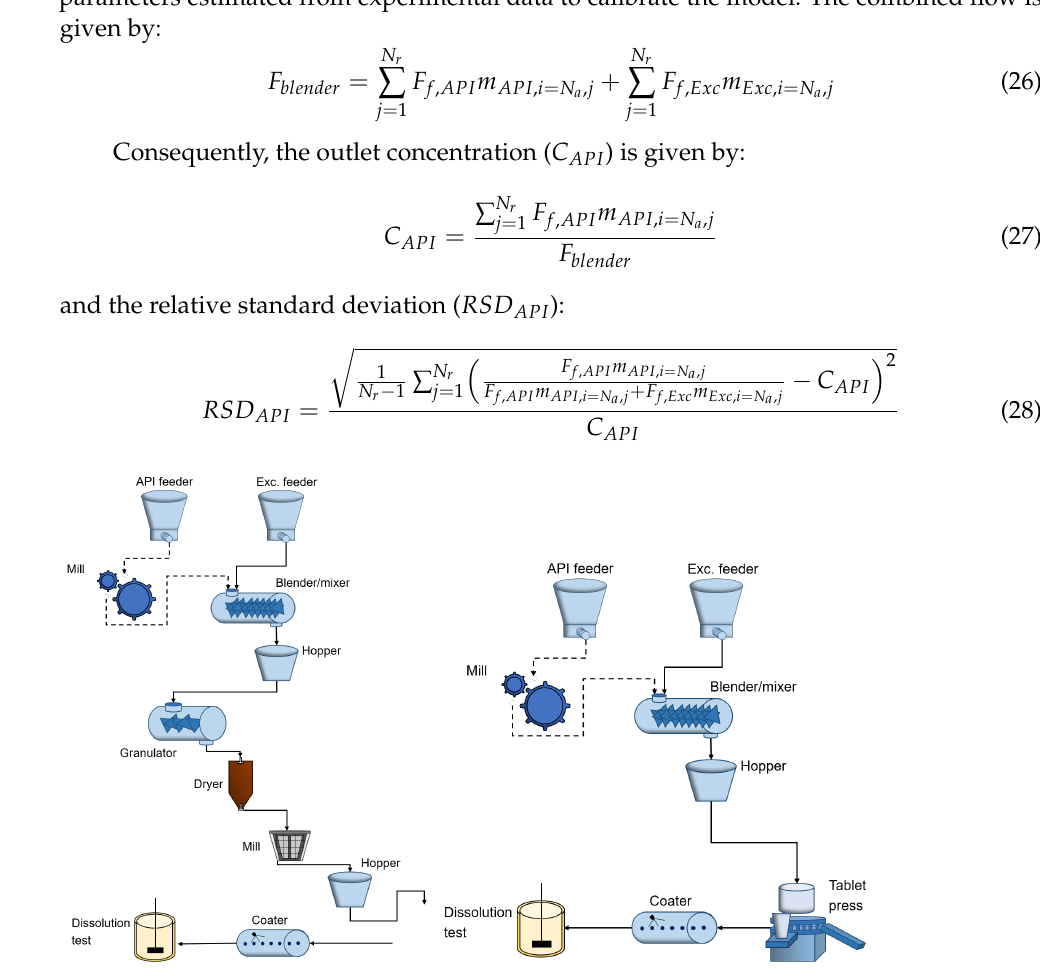
Figure 5. Continuous pharmaceutical tablet manufacturing processes: wet granulation ( left ) and direct compaction ( right ) routes.